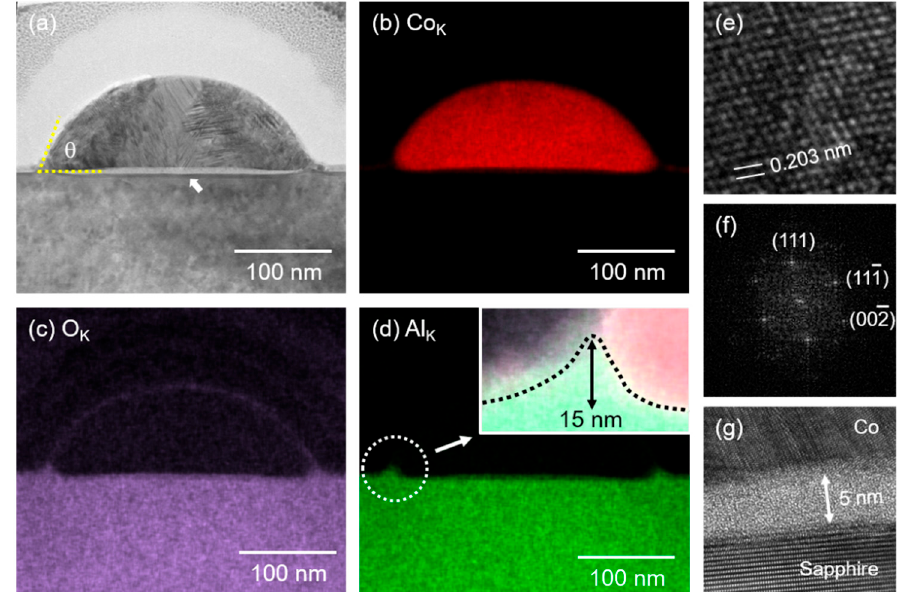
Figure 3. TEM results of an individual Co NP in the 200-pulsed sample irradiated under vacuum. ( a ) Low-magnification TEM image. Corresponding energy-dispersive X-ray (EDX) mapping images of Co K ( b ), O K ( c ), and Al K ( d ) emissions are illustrated. The inset in ( d ) shows the left corner of the wetting ridge near the contact line obtained with a higher magnification. The wetting ridge consists of Al and O. ( e ) High-resolution TEM image. ( f ) Fast Fourier transform (FFT) pattern of the Co crystalline domain corresponding to ( e ). ( g ) High-resolution TEM image highlights the amorphous Al 2 O 3 interlayer between the Co NP and sapphire substrate.